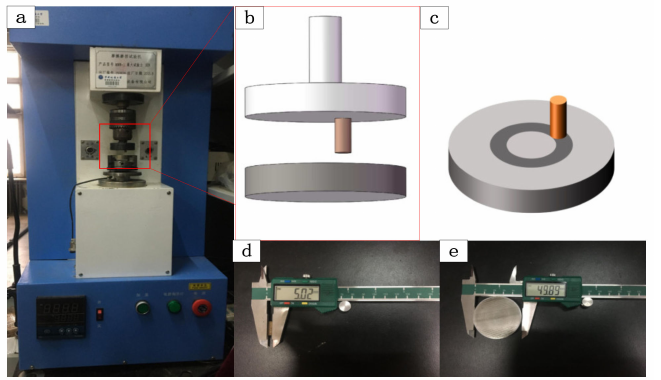
Figure 2. Tribological set-up and the tribo-pair. ( a ) Test rig; ( b ) schematically 3D diagram of the tribo-pair; ( c ) 2D surface profile of typical upper specimen; and ( d , e ) photographs of the pin and disc,